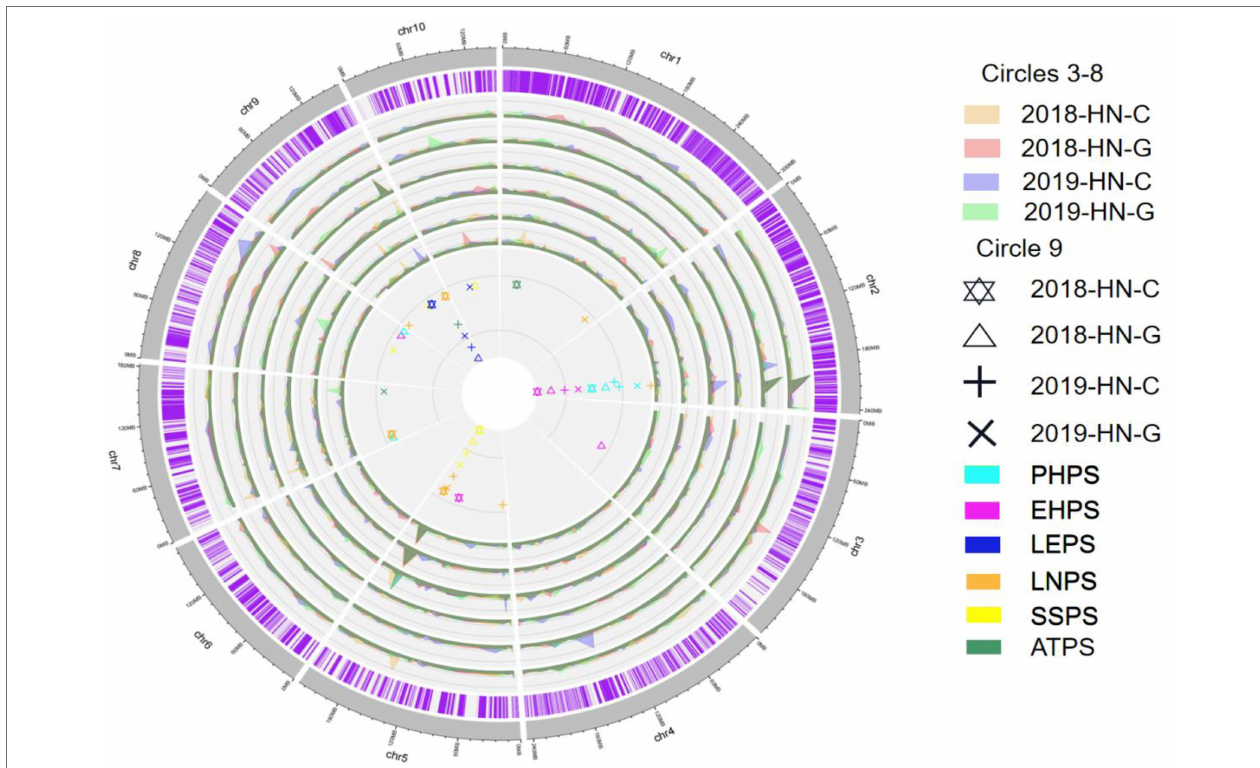
FIGURE 6 | Photoperiod sensitivity-related QTL detected for the RIL population in the four environments. Circles 1–2 are chromosomes; Circles 3–8 are LOD values; Circle 9 indicates the QTL